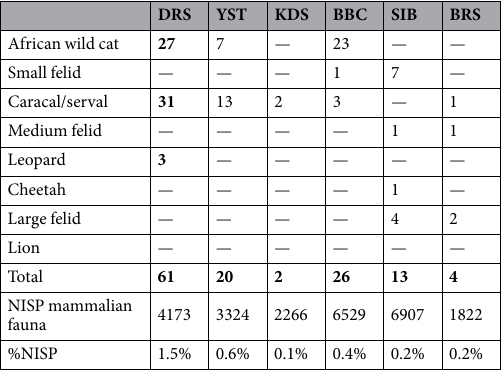
disarticulation and defleshing- are absent from the assemblage. From existing observations, there is no evidence for meat removal. Interestingly, claws, which are relatively easy to identify and characterized by moderate mineral volume densities in canids 53 , are absent from the assemblage. They could have been extracted, used and dis- carded outside of the site. Alternatively, their absence at the site, combined with the placement of cut-marks and considering that skinning marks cannot occur on elements left inside the fur 11,39,56 , could suggest that skinning at DRS was performed by carefully removing the fur until the lowest possible level and cutting it between the intermediate phalanges and the claws, which would have been left inside. Other skinning methods would involve cutting the fur higher up (i.e. at the wrist/ankle joint or between the metapodials and the proximal phalanges 11,56 ) and would result in more bones -not bearing cut-marks- left inside the fur. The pattern observed at DRS speaks in favour of the intentionally careful removal of the most complete possible furs, presumably in anticipation of their use.